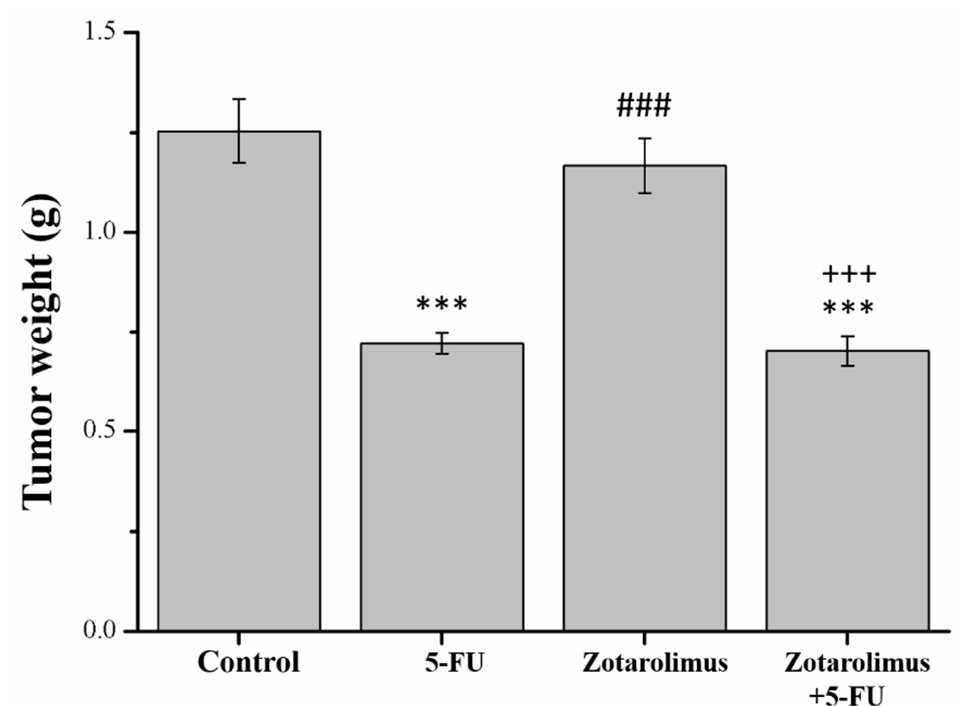
Figure A1. Tumor weight in BALB/cByJNarl mice post-sacrifice, after mice were provided different treatments, including control, 5-FU (100 mg/kg/week), zotarolimus (1 mg/kg/day), and zotarolimus (1 mg/kg/day) combined with 5-FU (100 mg/kg/week). All data are presented as mean ± standard deviation, n = 7 per group. *** p < 0.001 compared with the control group. ### p < 0.001 compared with the 5-FU-treated group. +++ p < 0.001 compared with the zotarolimus-treated group.